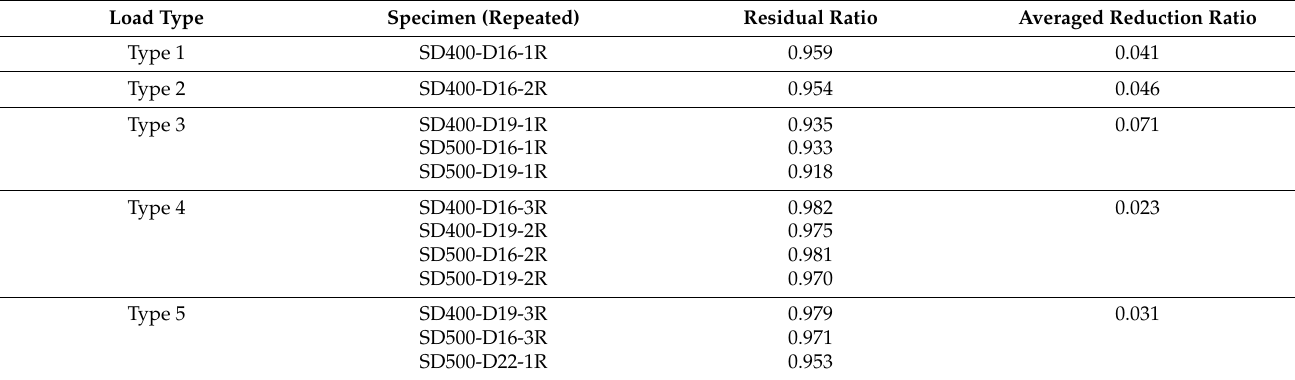
Table 11. Shear resistance degradation by load types.